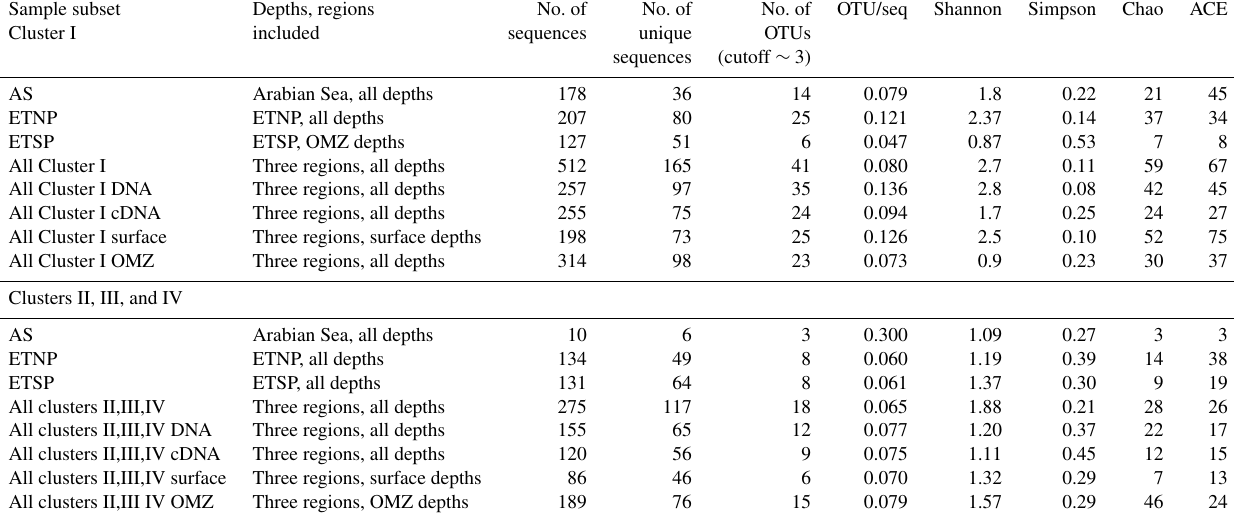
Table 2. OTU Summary. OTU summary for both clusters. Richness and diversity statistics for nifH clone libraries from three OMZ regions. ACE and Chao are nonparametric estimators that predict the total number of OTUs in the original sample. Sample